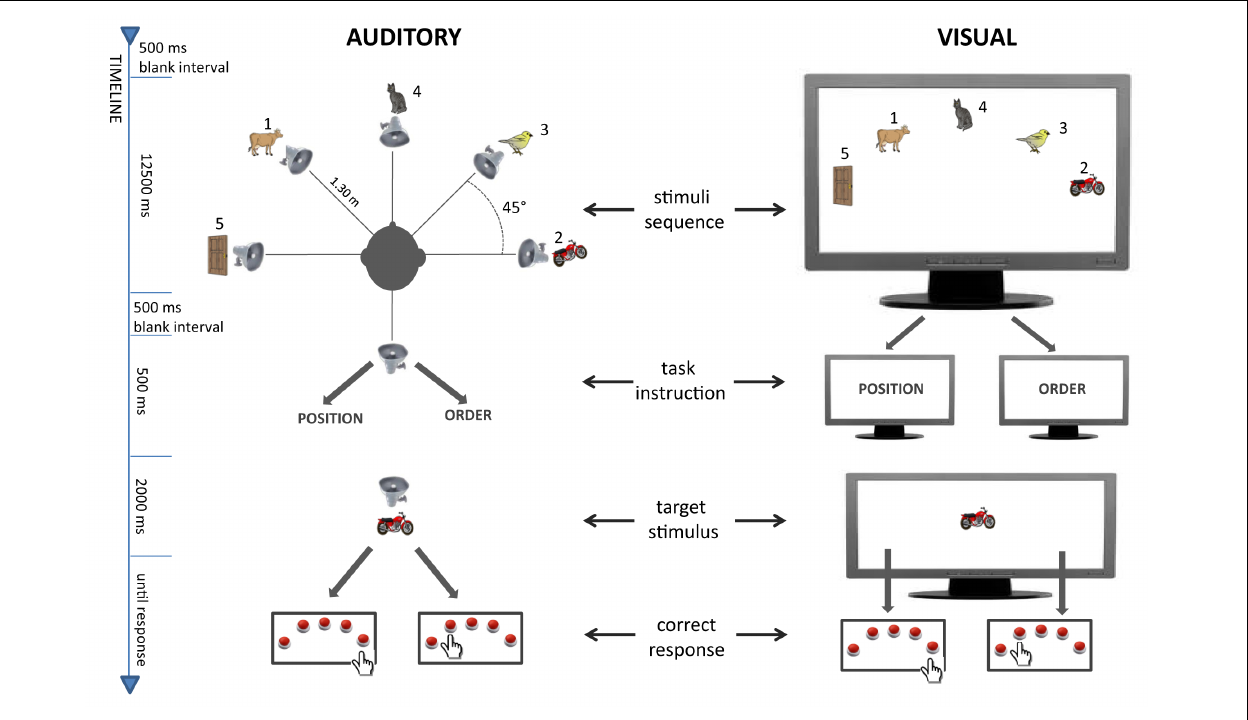
FIGURE 1 | Sequence of events in the auditory and visual